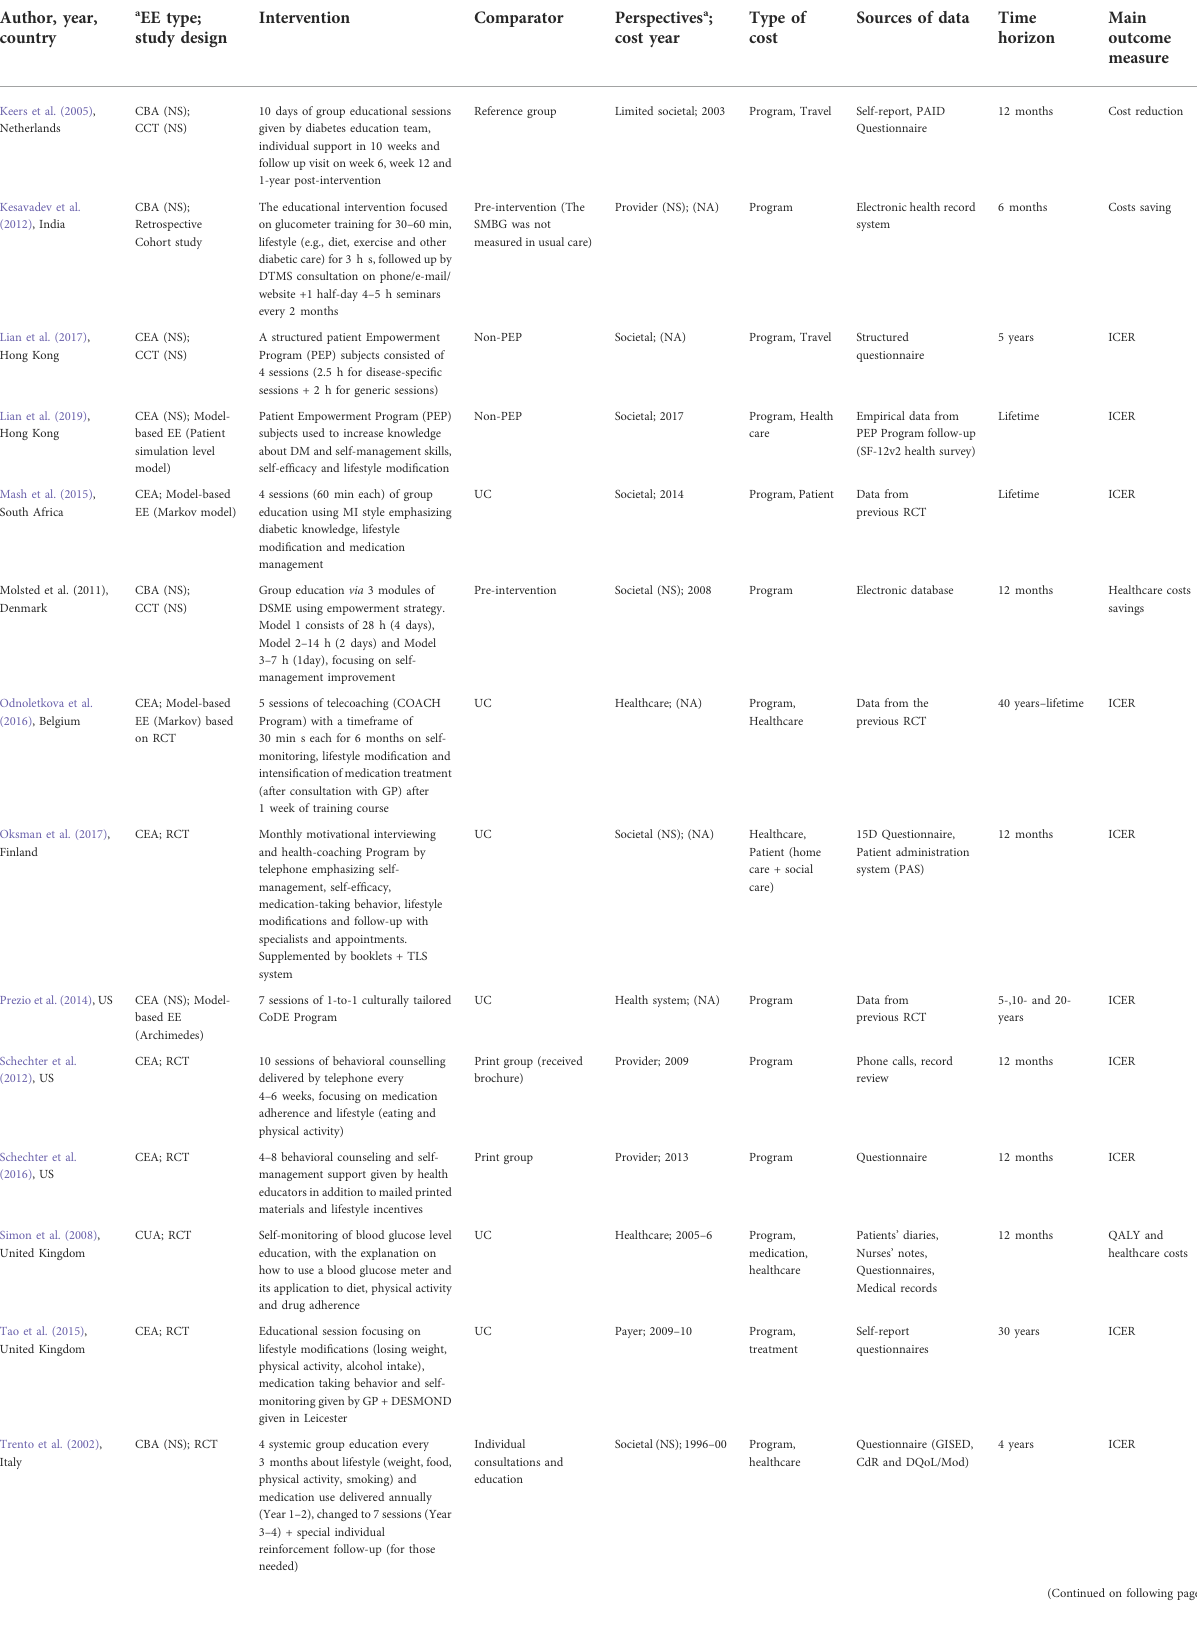
TABLE 1 ( Continued ) Study characteristics of a systematic review of the cost-effectiveness of different types of educational interventions in type II diabetes